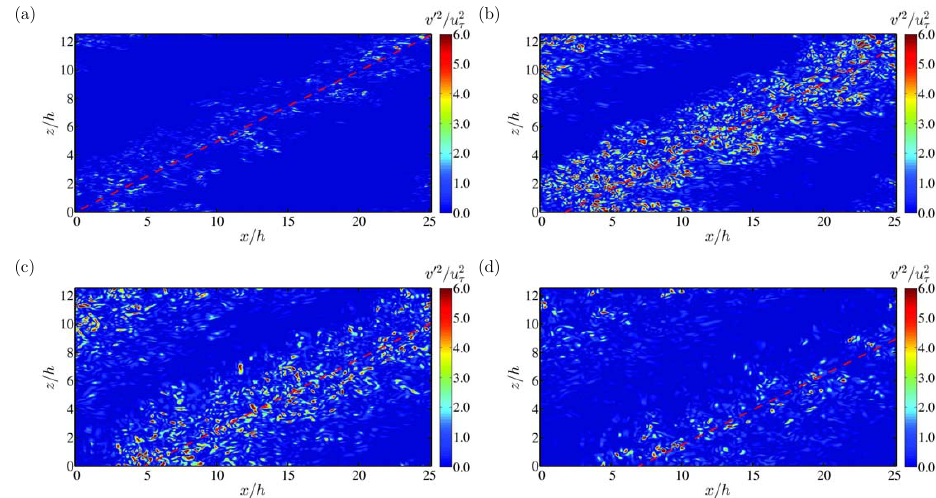
Figure 10. Instantaneous contours of v (cid:48) 2 at different horizontal planes ( Re τ = 180, Ri τ = 120). The red-dashed line denotes the approximate center of the turbulent bands. (a) y + = 10, (b) y + = 45, (c) y + = 90, and (d) y + =